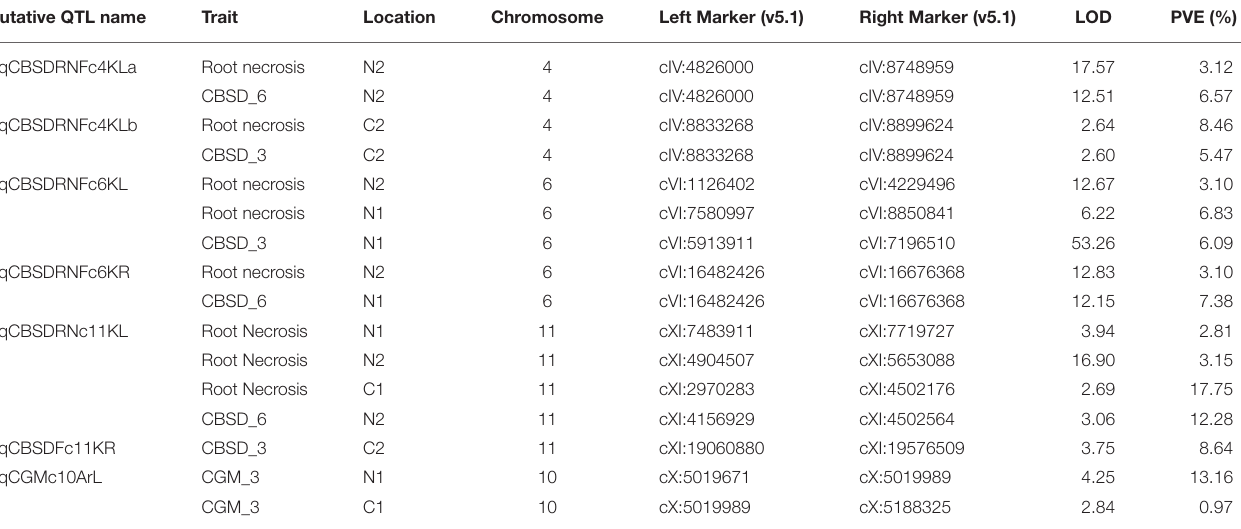
TABLE 4 | Main Putative QTL in the biparental mapping population between Kiroba and AR37-80. Putative QTL